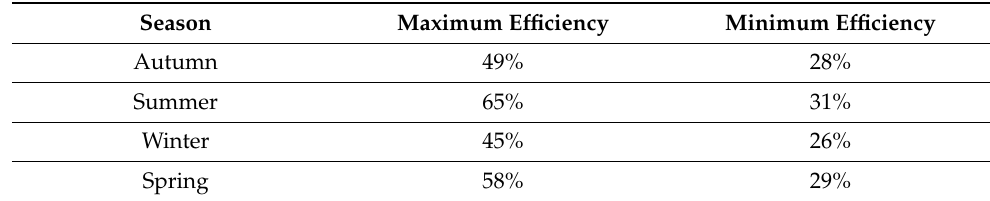
Table 3. PVT panel overall efficiency.